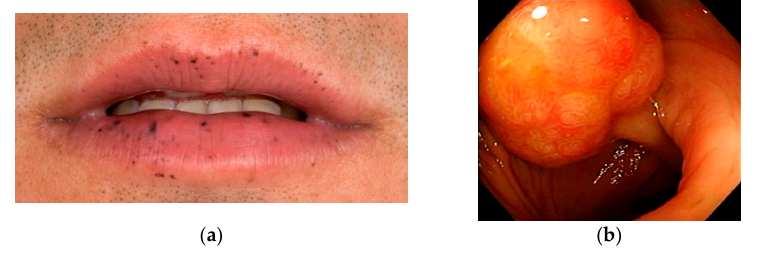
Figure 1. Pigmentations ( a ) [6] and polyp ( b ) characteristic for Peutz–Jeghers syndrome. Table 1. Diagnostic clinical criteria for Peutz–Jeghers syndrome (PJS).